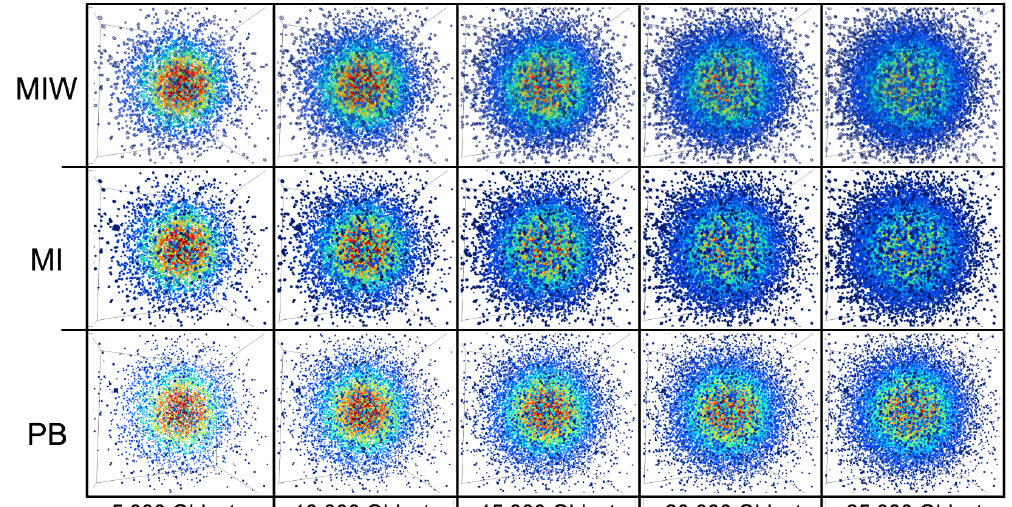
Figure 6. Comparison between the Point Buffer Geometry ( PB ), the Mesh Icosahedron Geometry ( MI ) and the Mesh Icosahedron Geometry Wireframed ( MIW ) representing the same data with different number of